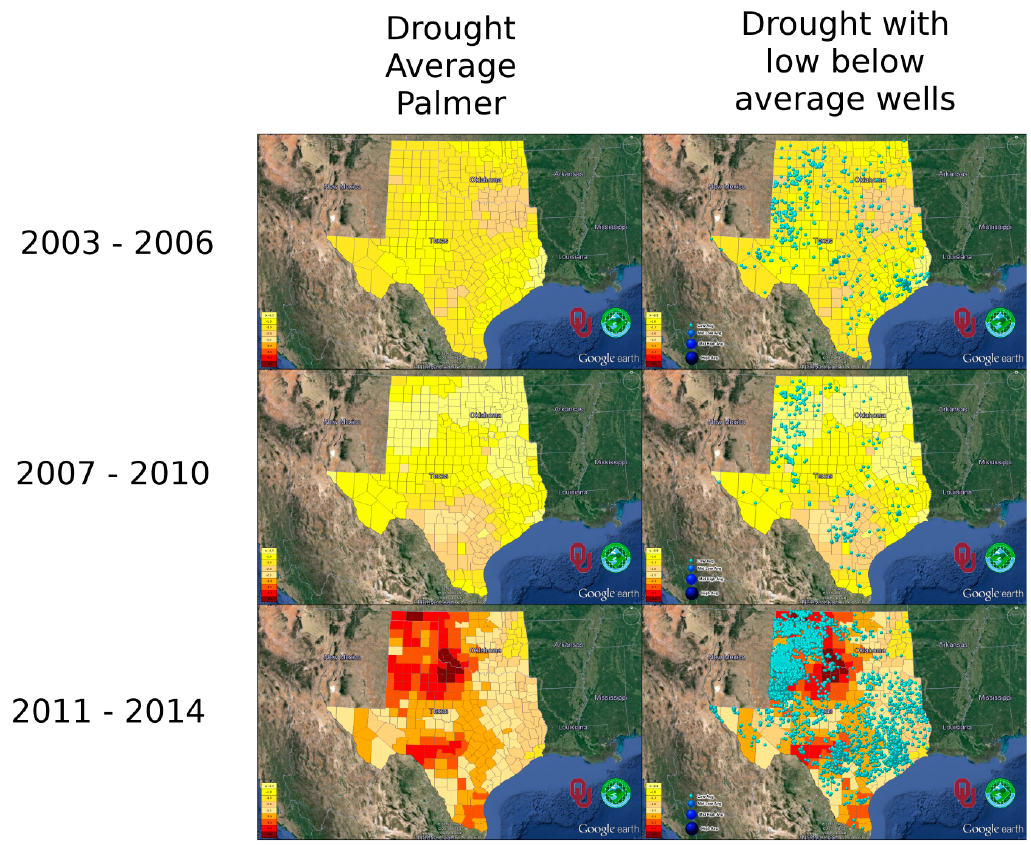
Figure 11. Palmer Drought Severity Index (PDSI) and groundwater wells with the highest water scarcity in 2003–2014. Source: Authors’ calculations and visualization.